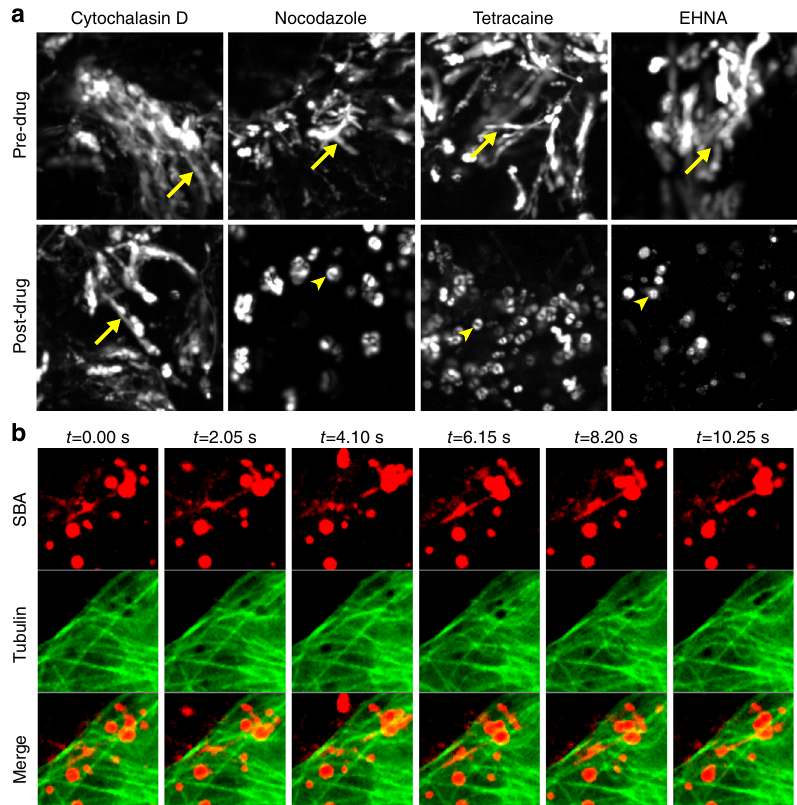
Fig. 7 Vesicular RSV fi lament formation is microtubule and dynein dependent. a Vero cells were infected with RSV A2 at an MOI of 1. At 12 hpi, SBA-488 was delivered to the cells and allowed to internalize for 1 h. Cells were then imaged live brie fl y at 9 Hz prior to drug delivery to verify the presence vesicular fi lament formation. Cells were then treated with nocodazole to disrupt microtubules, cytochalasin D to disrupt actin fi laments, tetracaine to inhibit molecular motors, or EHNA to inhibit dynein before being imaged live again. Data is presented as SD maps over 30 s of imaging. Yellow arrows indicate fast motion, shown as streaks, while yellow arrowheads indicate slow motion, shown as hollow circles . Scale bars represent 5 µ m. b Tubulin-GFP ( green ) was expressed in Vero cells overnight prior to infection with RSV A2 at an MOI of 1. At 12 hpi, SBA-647 ( red ) was delivered and allowed to internalize for 1 h. Cells were then imaged live at 4.9 Hz. Scale bar represents 3 µ infected cells with RSV A2 for 12 h before labeling RSV G with SBA-488. After 1 h, cells were imaged live every 10 min for 12 h (Fig. 6c; Supplementary Fig. 2; Supplementary Movie 2). As expected, we found that RSV fi laments extended rapidly from vesicles within a single frame. Furthermore, some of these fi la- ments persisted for a long period of time, suggesting that they had matured from the vesicular extension and retraction phase. These results indicated that RSV fi laments are formed by a rapid extension/retraction process of intracellular vesicles before reaching the plasma membrane.